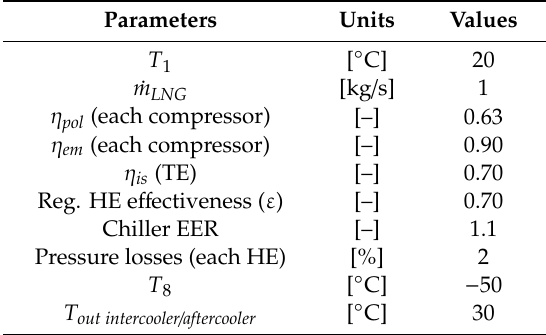
Table 1. Assumptions for parametric